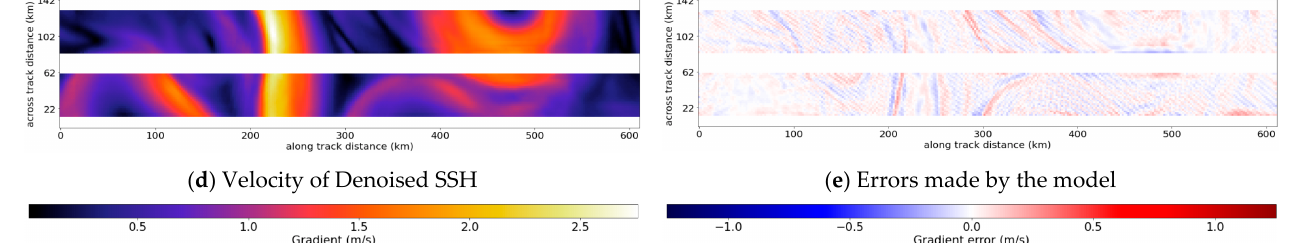
Figure 4. Velocity of ( a ) True SSH, ( b ) Noisy SSH, ( d ) SSH denoised by the U-Net and ( c , e ) their associated errors (Pass 496, cycle 17 located in the Gulf Stream).